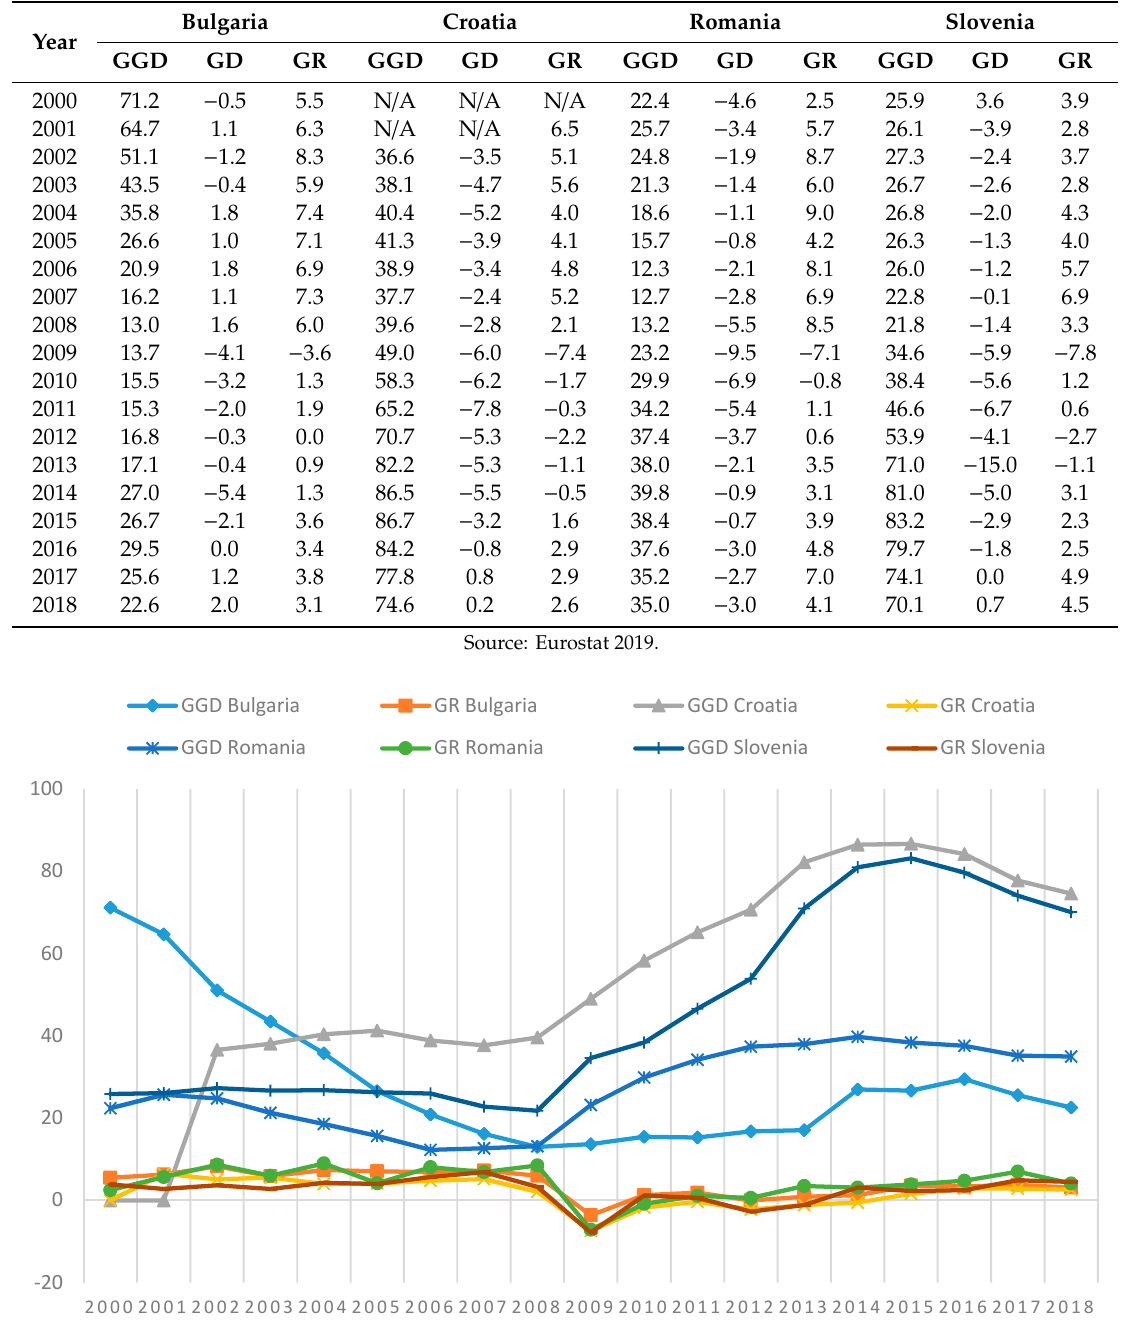
Figure 7. The Balkan countries’ GD percentage of GDP versus growth rate percentage change from previous year, 2000–2018; Source: Eurostat. 5. Discussion 5.1. Tax System Evaluation An evaluation of the varying tax systems from each of the eleven EU MSs were assessed to further understand comparability and best practices. Two tax baseline indicators were considered in